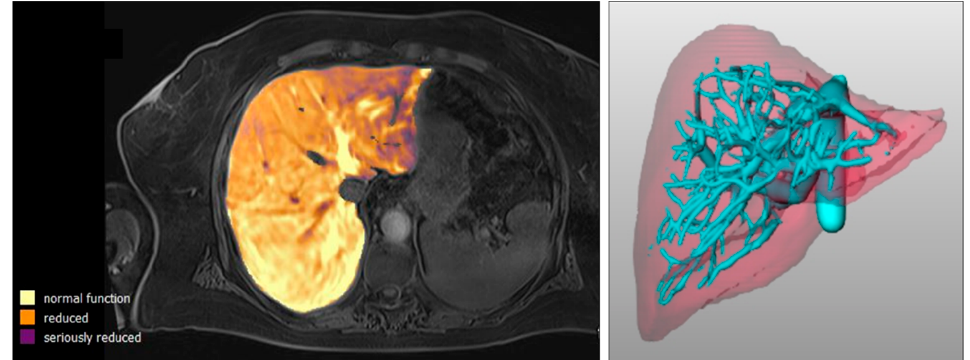
Figure 1. Example of image analysis. Visualization of liver function over the entire liver with the AI-based software prototype ( left ) and 3D view of the liver and vascular supply ( right ).